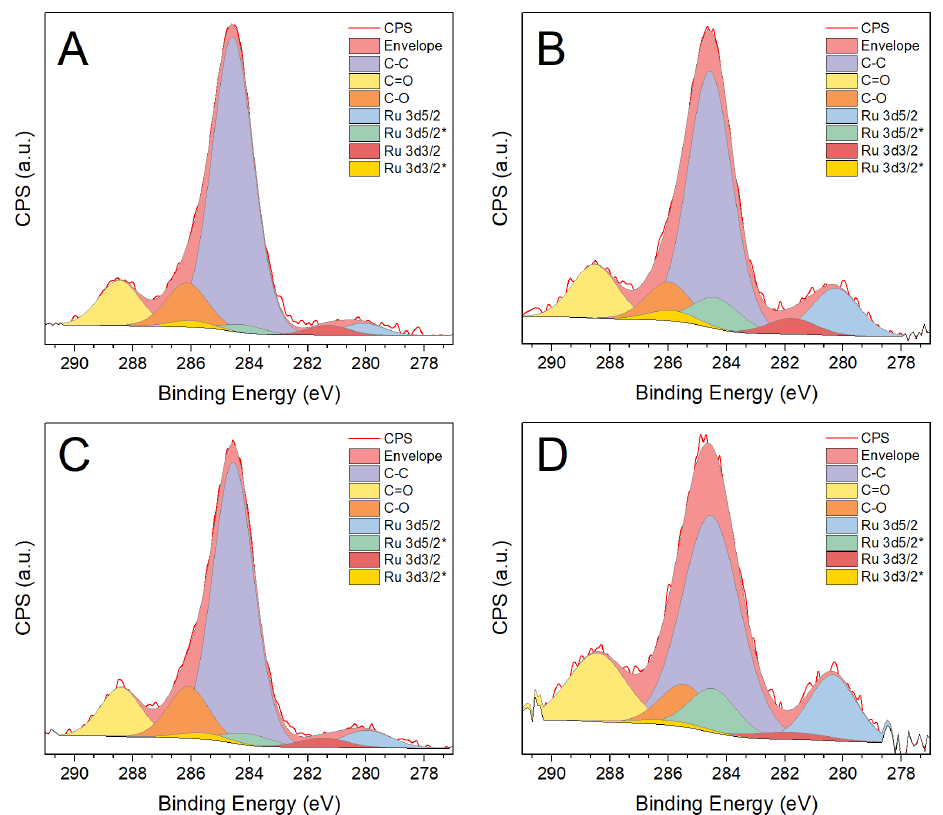
Figure 4. X-ray photoelectron spectra of Ru/TiO 2 catalysts in the Ru 3d + C 1s region: Ru-14 ( A ), Ru-28 ( B ), Ru-41 ( C ) and Ru-70 ( D ). Asterisks denote the Ru δ + components.